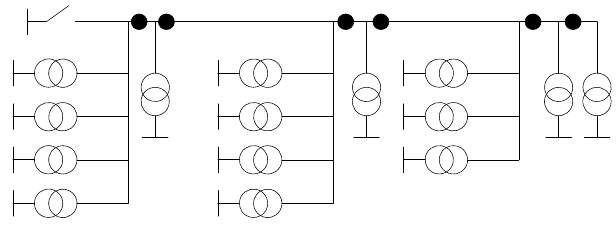
Figure 3. Switch alternative-location diagram (no contact).